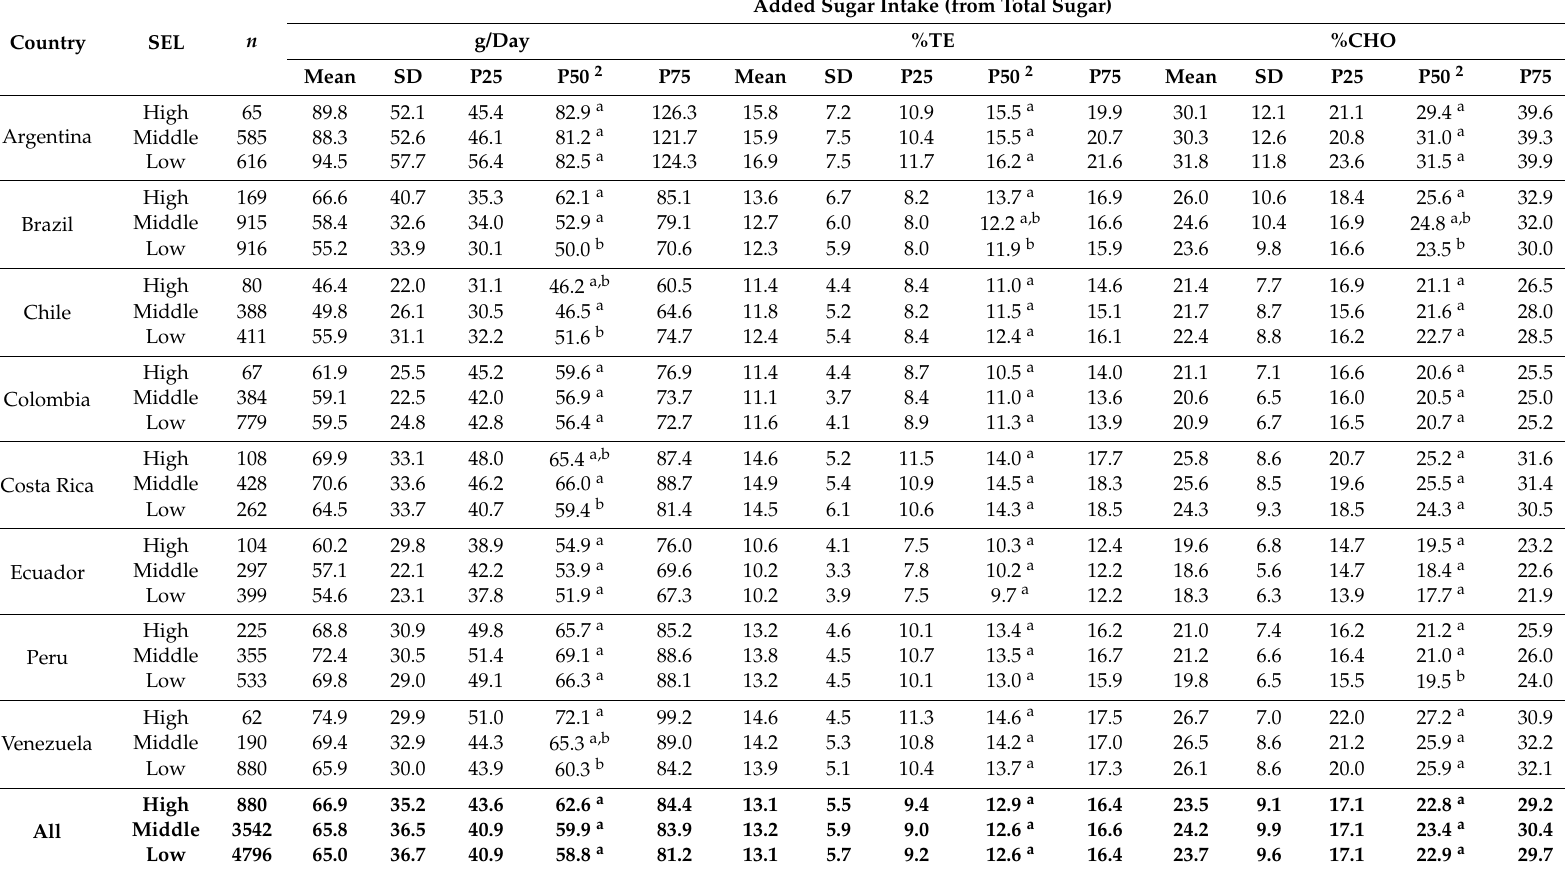
Table 6. Added sugar intakes 1 in individuals residing in urban areas of Latin American countries, according to socioeconomic level; Latin American Health and Nutrition Study (ELANS),